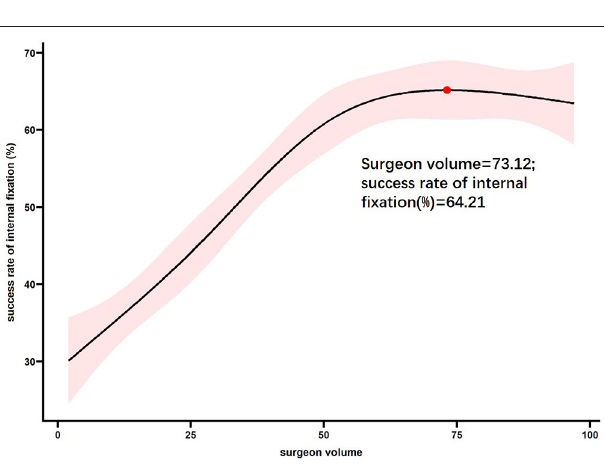
FIGURE 2 | Probability of success rate of internal fixation according to surgeon